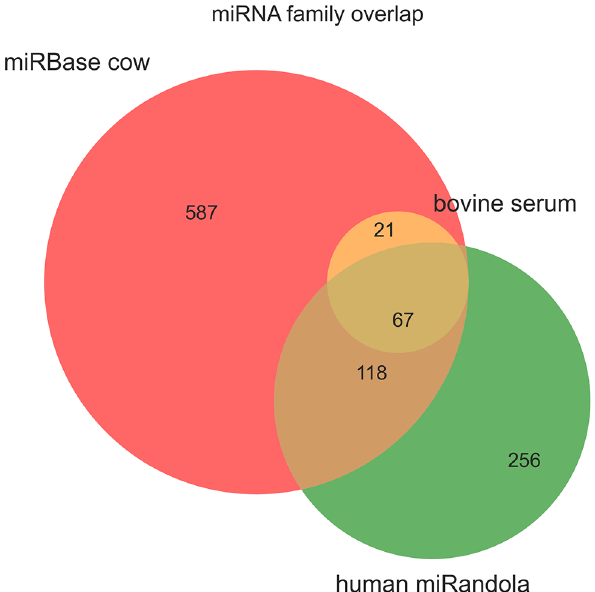
Fig 4. Overlap between core miRNAs in this study and known databases. The known bovine miRnome from miRBase 1.2 is in red. The green set are currently annotated extracellular circulating miRNA human families from the miRandola database. The yellow set represents our core bovine